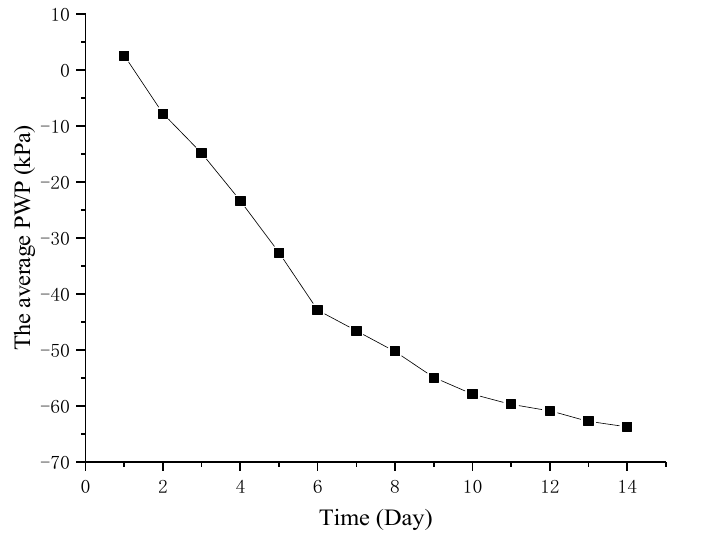
Figure 6. The average pore water pressure dissipation recorded during the vacuum consolidation of the dredged slurry.